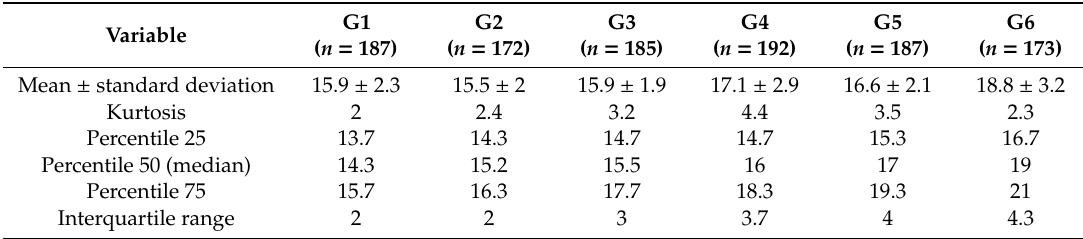
Table 3. Percentiles and descriptive statistics (in seconds) for the duration of the gait test by age